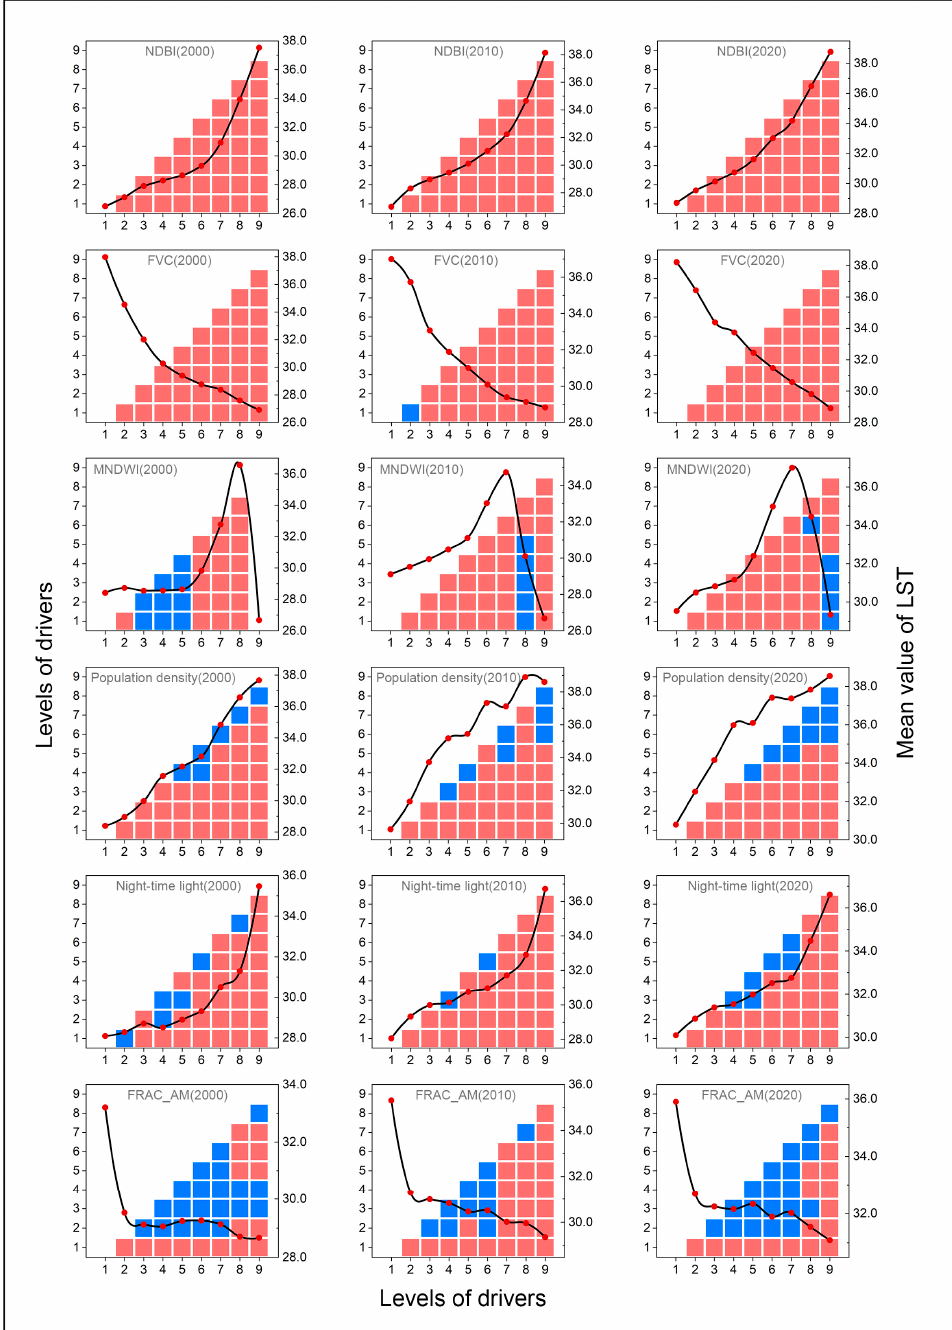
Figure 10. Results of the landscape-level risk detector. (Curves represent the change in the mean LST at various levels for each driver. Red squares denote that the difference in effect on LST between the two factor levels is signi fi cant with 95% con fi dence. Blue squares denote insigni fi cance.).